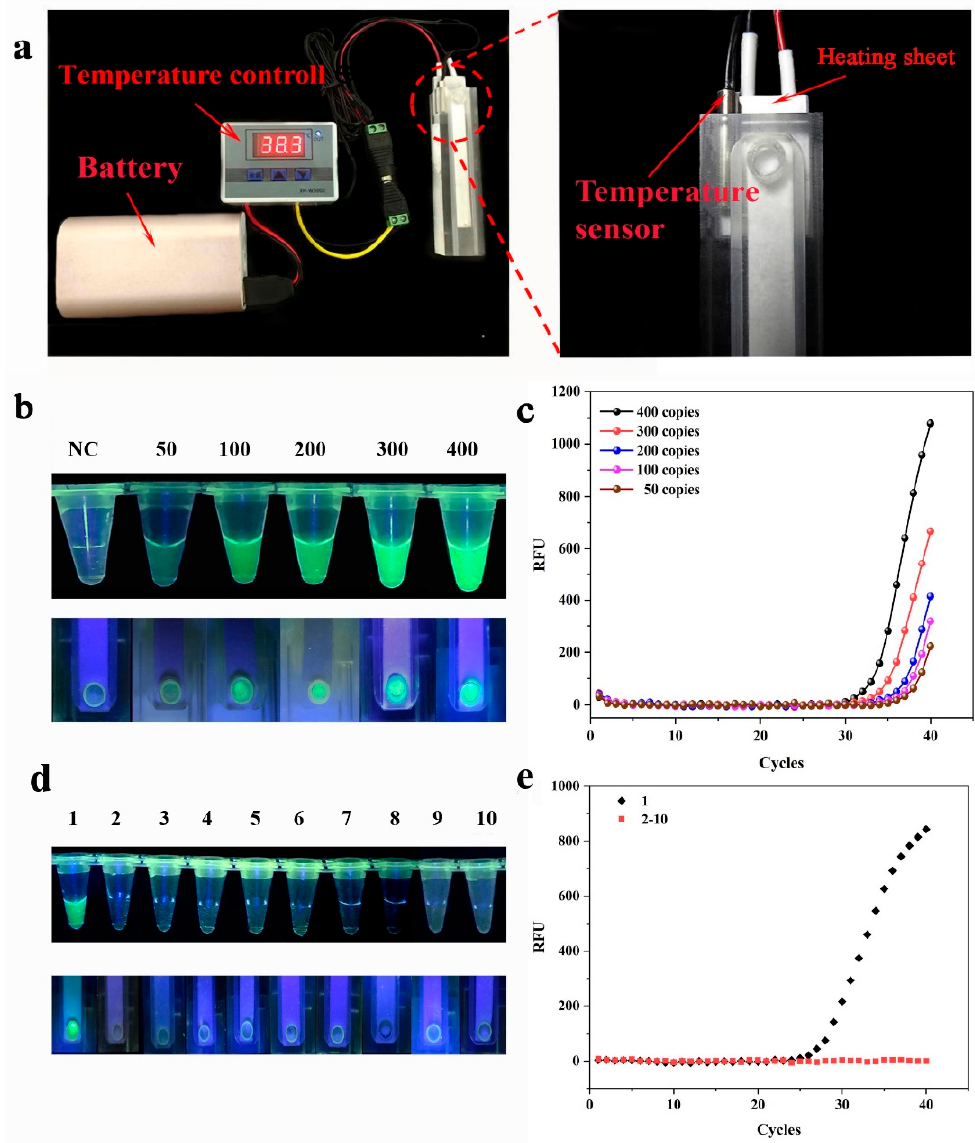
Figure 5. Sensitivity and specificity of SMART: ( a ) the photo of the SMART amplification module; the image on the right is of the temperature probe and the heating plate; ( b ) sensitivity performance of SMART and RPA with different copy concentrations of genomic DNA; visual detection results of RPA in the laboratory (top panel); visual detection results of SMART (bottom panel); ( c ) sensitivity of the GM DR12-5 using RT- PCR; ( d ) the visual detection results of specificity; the visual detection results of the RPA in the laboratory (top panel); visual detection results of SMART (bottom panel); 1: the GM maize DR12-5; 2, 3, 4: the GM rapeseed MS1 × RF1; 5, 6, 7: the GM soybean 356043; 8, 9, 10: the GM corn NK603; ( e ) the specificity of the different sample DNA was detected using RT-PCR.